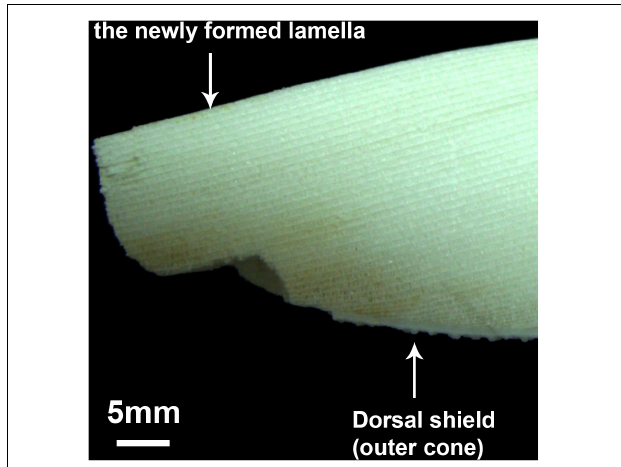
FIGURE 1 | Longitudinal transection of a cuttlebone. The layers represent the structural units, lamellae, of the inner cone of a